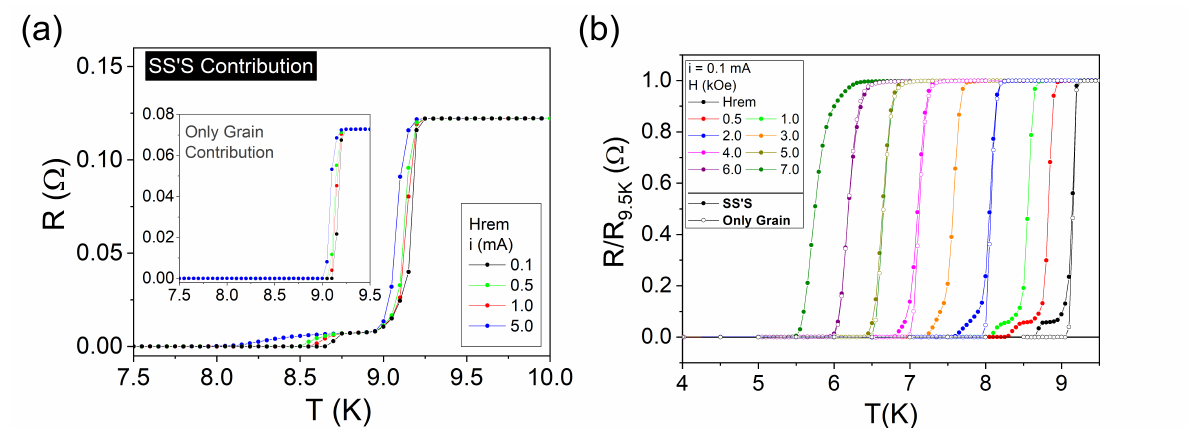
Figure 3. (Color online) ( a ) Temperature-dependent resistance curves for the SS’S contribution (main panel) and for the grain region (inset) for different applied currents ranging from 0.1 to 5.0 mA at H rem . ( b ) Temperature-dependent resistance normalized by the resistance at 9.5 K for the SS’S contribution (closed symbols) at i = 0.1 mA and different applied DC magnetic fields ranging from remnant field to 7 kOe, and for remnant field, 2 kOe, 4 kOe, 5 kOe, and 6 kOe for the grain region (open